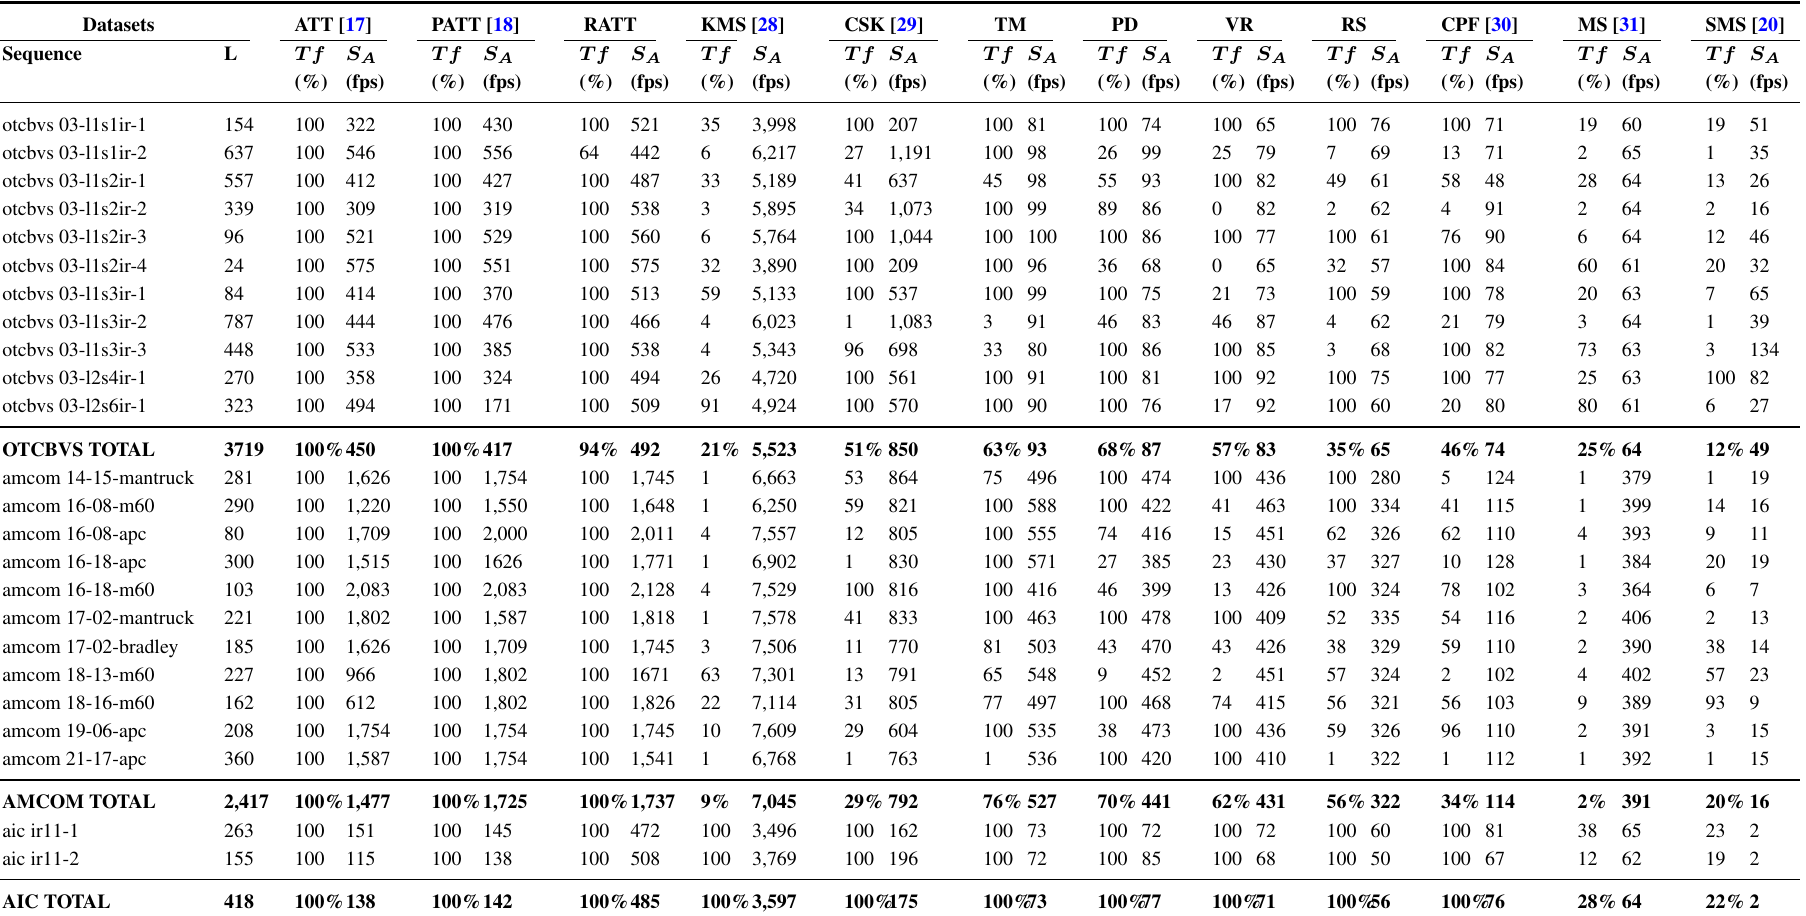
Table 5. A comparison of the percentages of tracked frames and the speed for different tracking algorithms applied to three datasets. TM, template